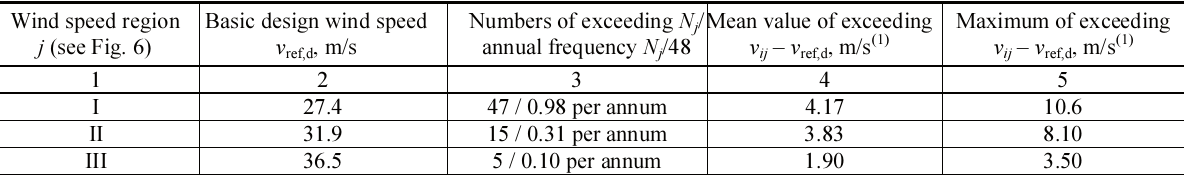
Table 4. Numbers of exceeding of the design wind speeds v ref,d specified in STR 2.05.04:2003 and corresponding frequencies of exceedance calculated for the 48 years period 1962 to 2009 Wind speed